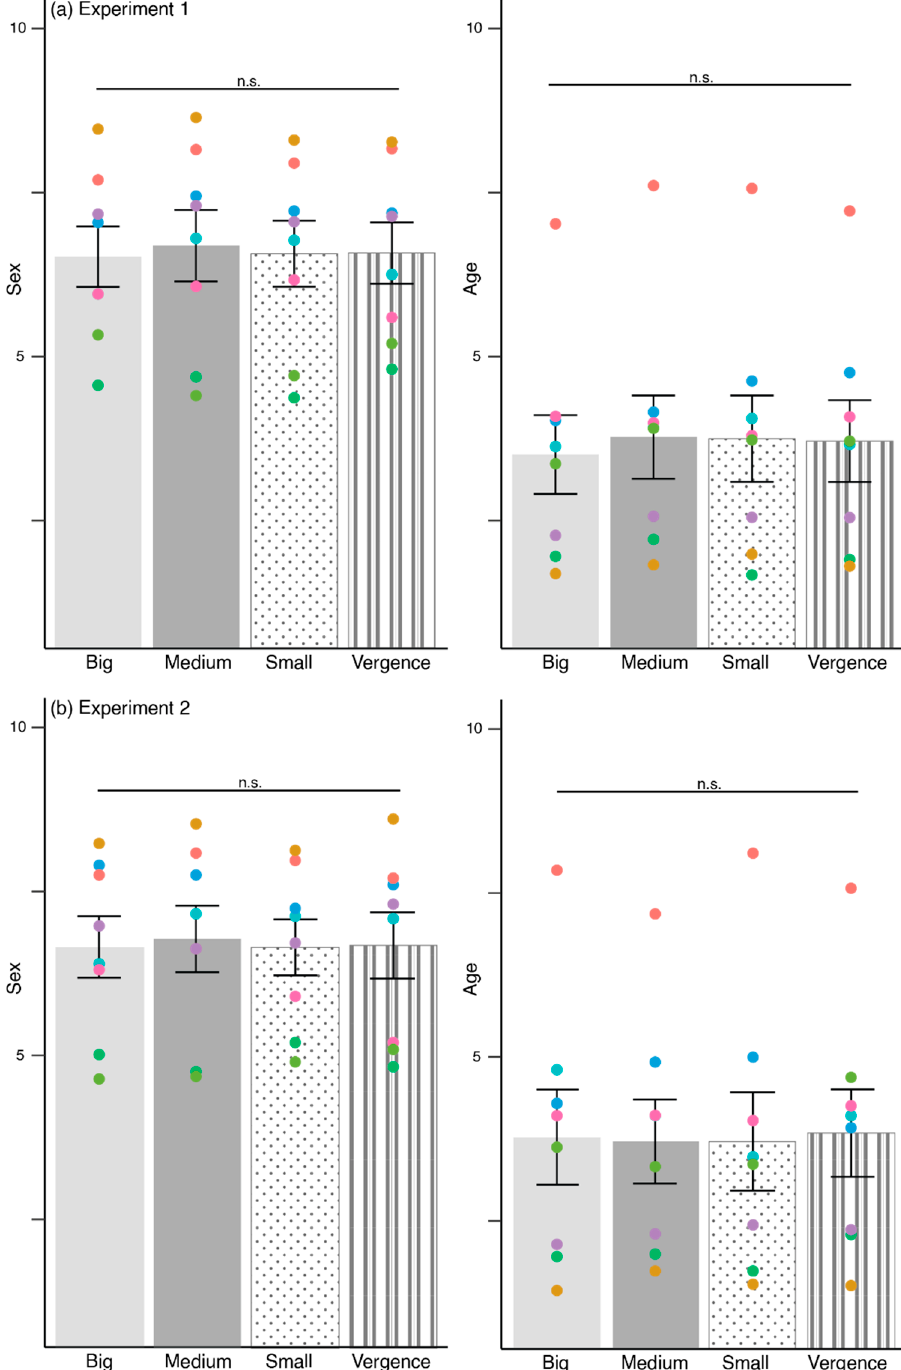
Figure 4. Sex and age ratings in ( a ) Experiment 1, and ( b ) Experiment 2 across big, medium, small, and vergence pupils. The colored scatter corresponds to each eye model. Error bars depict standard error of means, S.E.M. n.s.—non-significant.